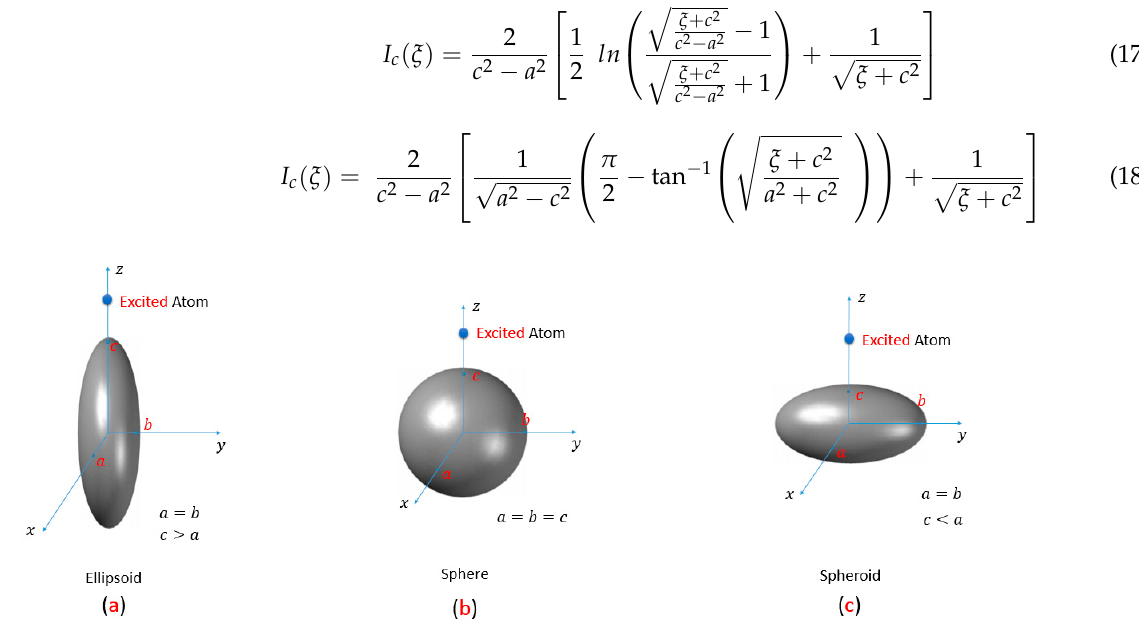
Figure 2. Simple sketch of the geometry of: ( a ) ellipsoid, ( b ) sphere, and ( c ) spheroid. The excited atom is located at different distances ( d ) from the close surface of the NP.